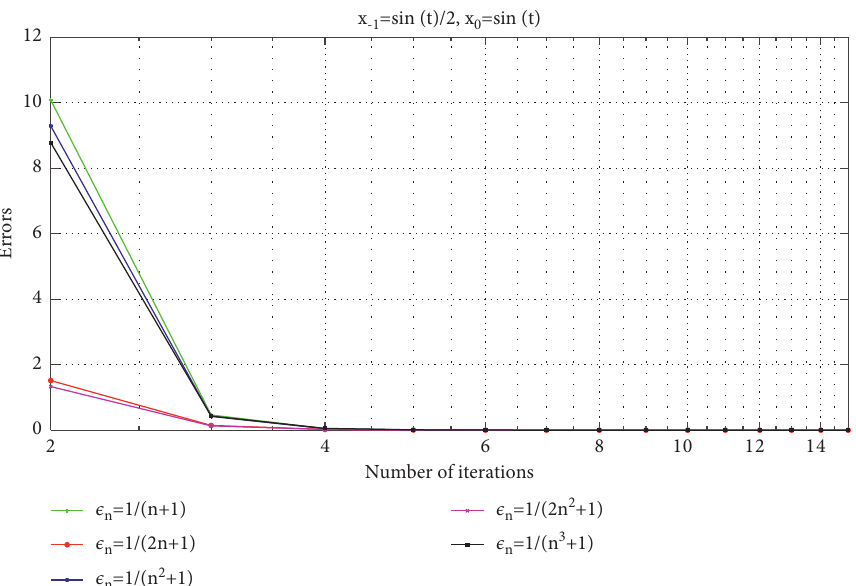
Figure 1: The Cauchy error plotting number of iterations for different parameters ε